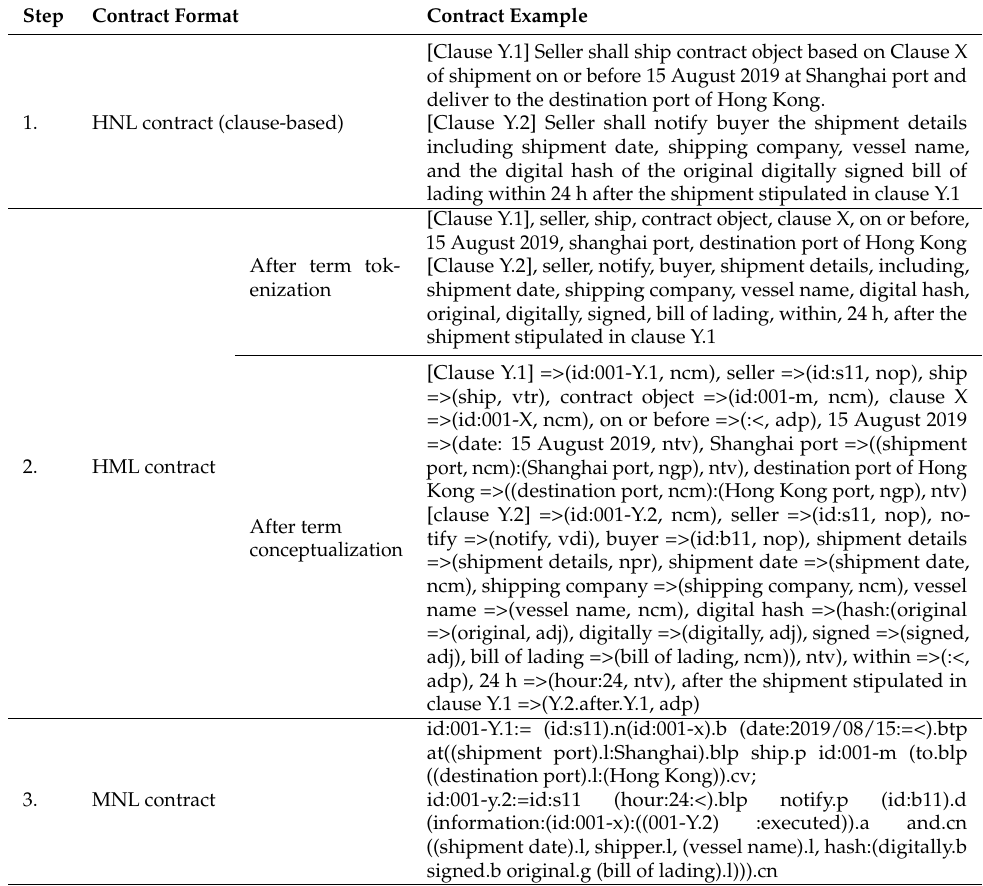
Table 1. An example of different representations for a contract